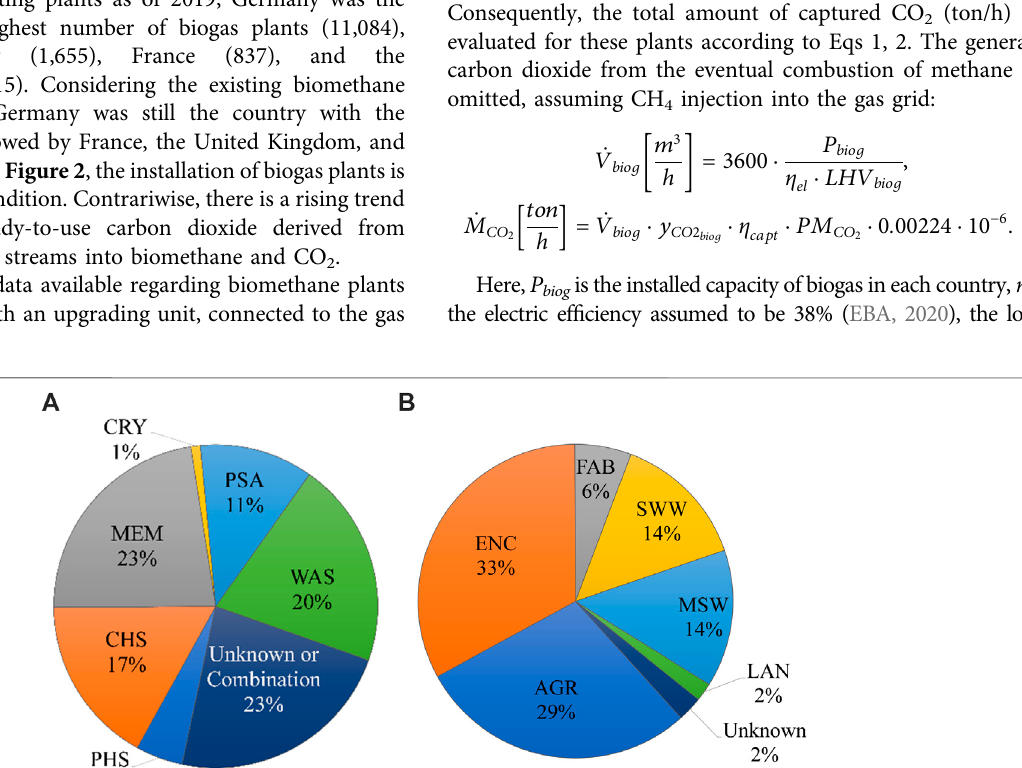
Frontiers in Energy Research |